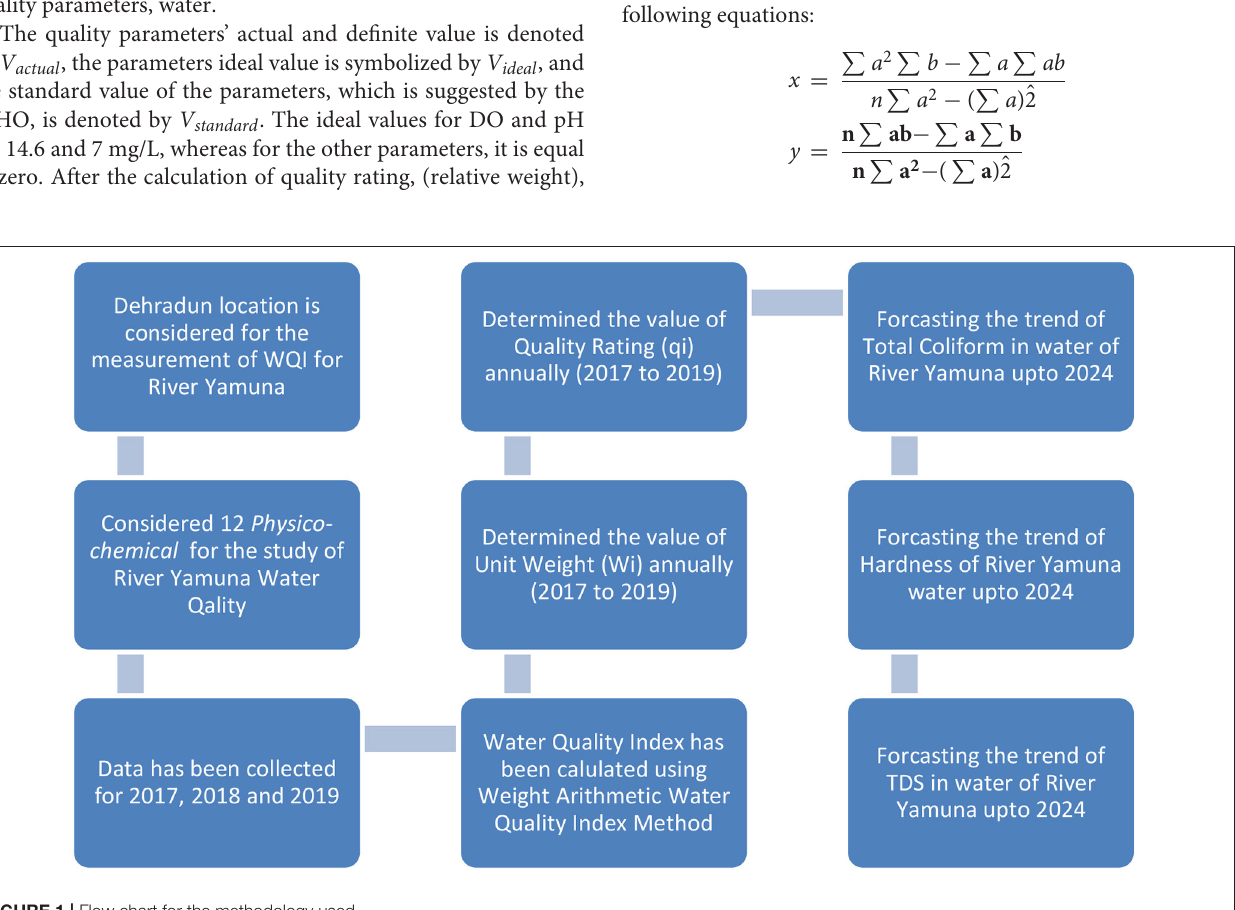
FIGURE 1 | Flow chart for the methodology